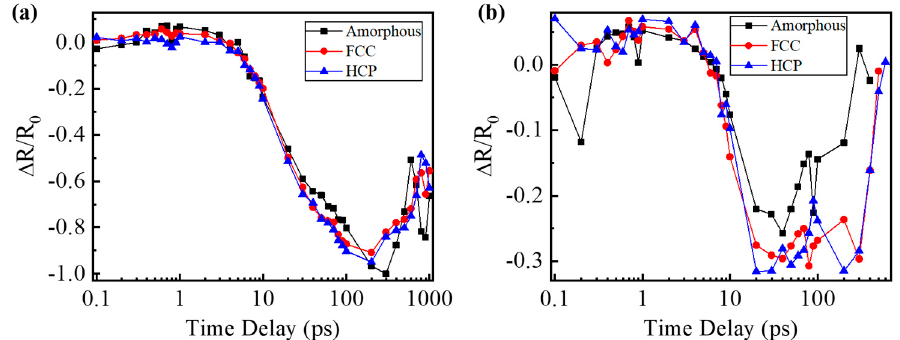
Figure 6. ( a ) Reflectivity dynamics of the zone irradiated by the relatively high laser fluence for different phase states films, ( b ) reflectivity dynamics of the zone irradiated by the relatively low laser fluence for different phase states films.